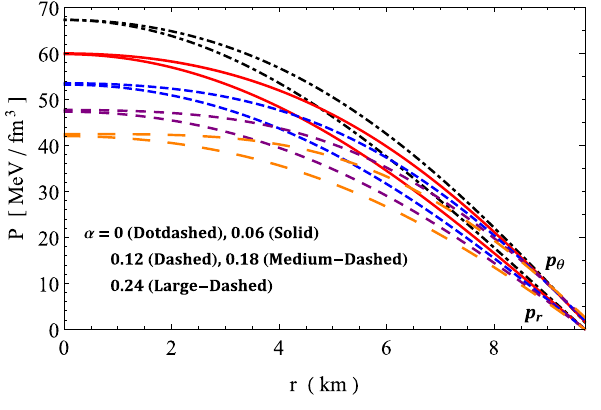
Fig. 6 Variation sound speed with r for M = 1 . 97 M (cid:3) , R =